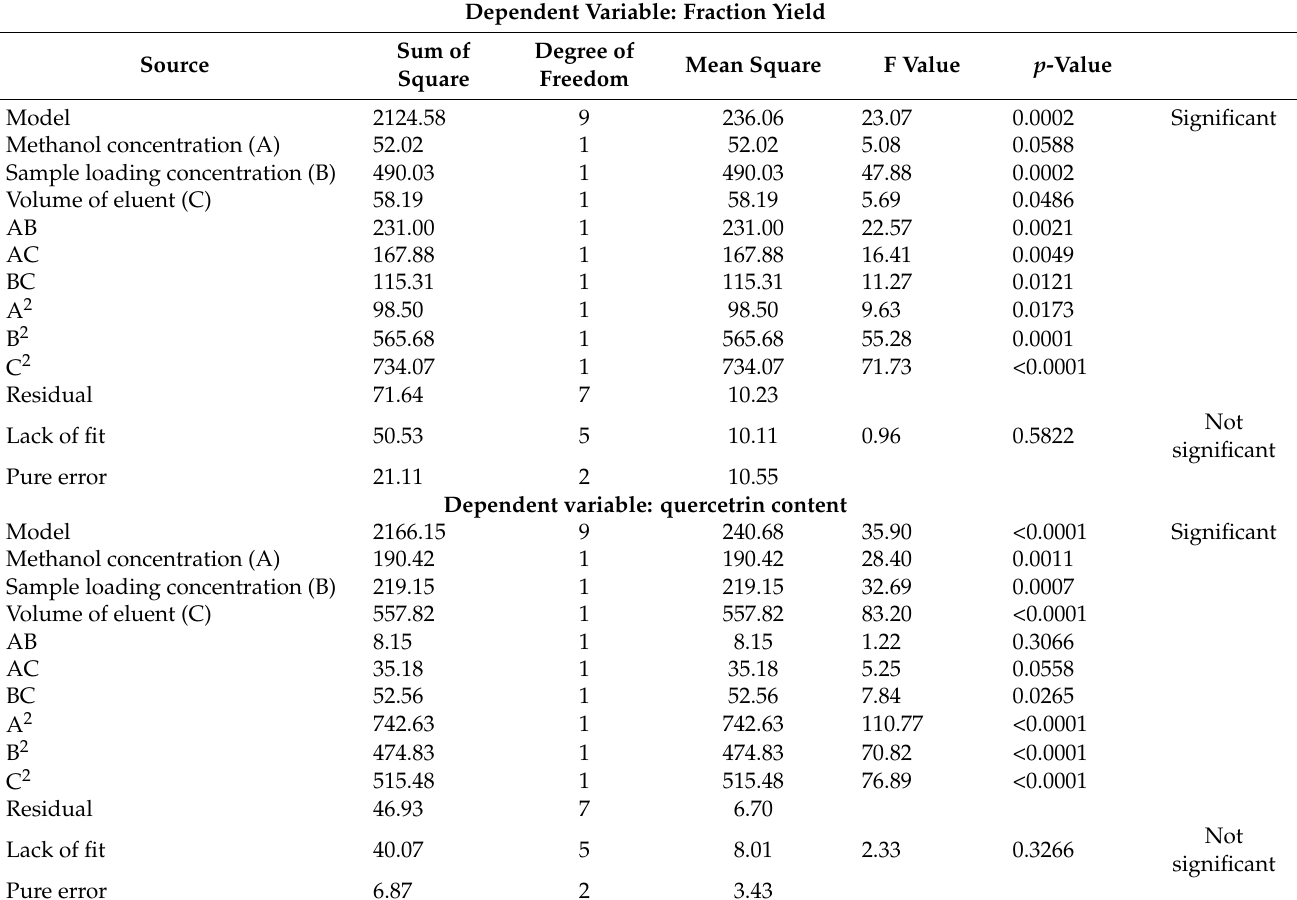
Table 2. Summary results for analysis of variance for the optimization models of both fraction yield and quercetrin content. Dependent Variable: Fraction